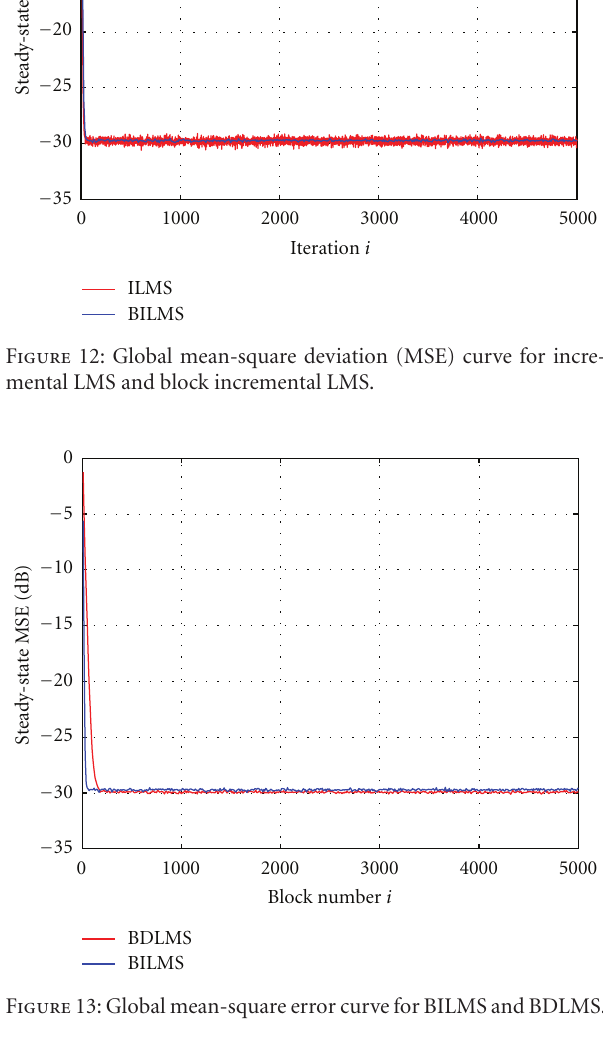
the same as that of DLMS. But, in case of BDLMS algorithm, each node distributes the message after L data